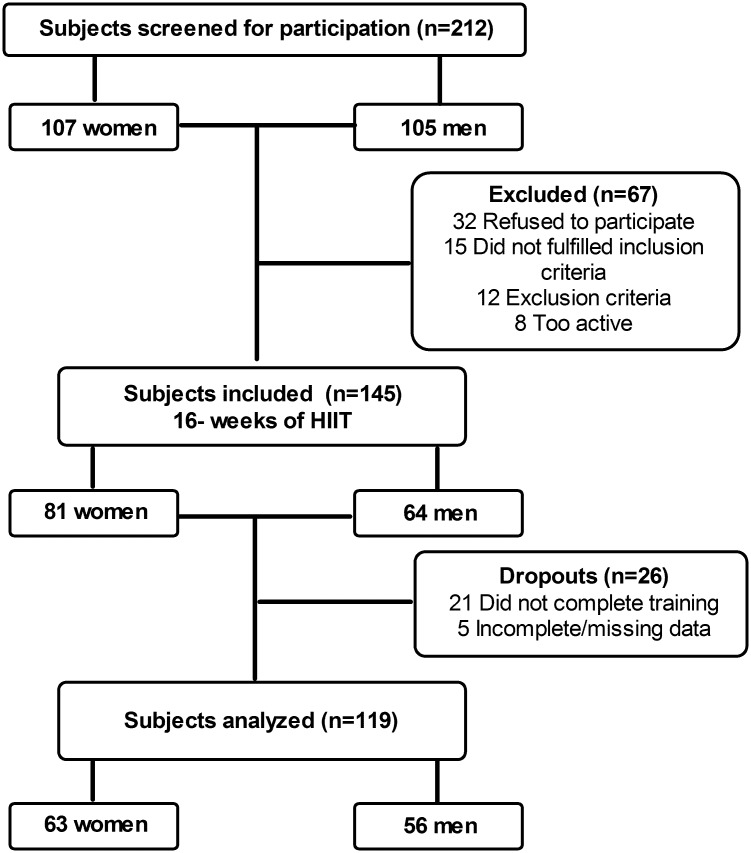
Flow chart of the Consolidated Standards of Reporting Trials (CONSORT) procedures followed in our study.